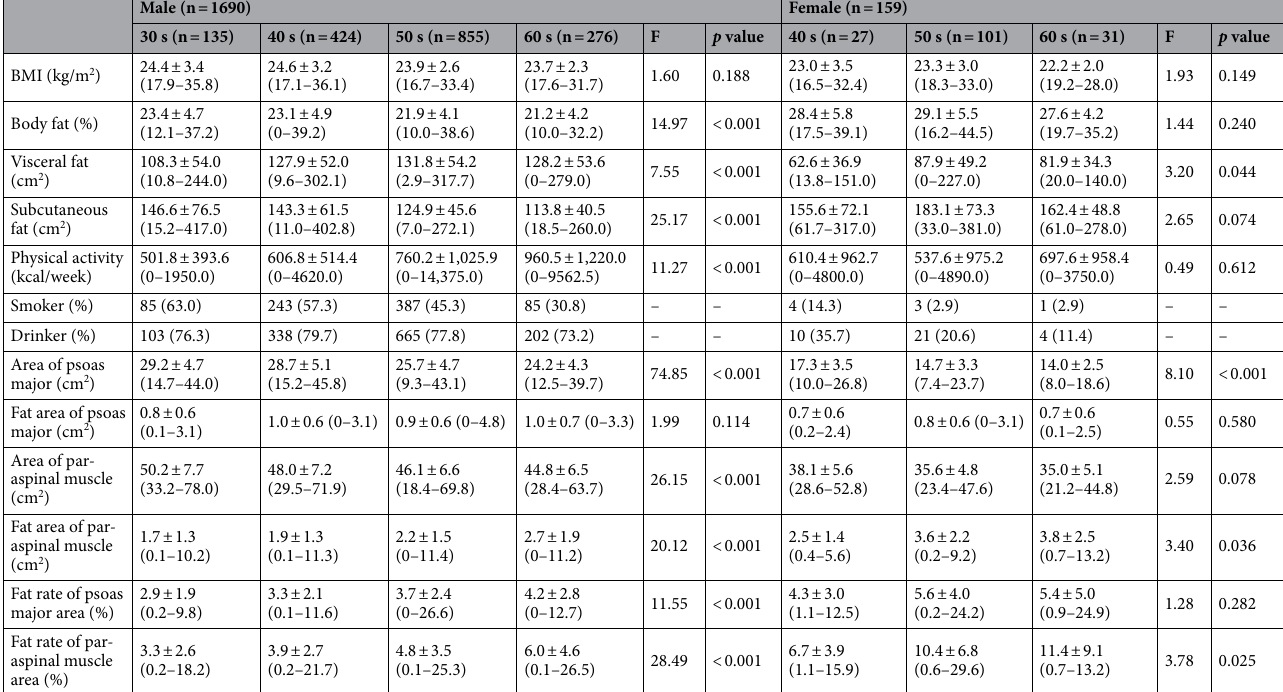
Table 1. Summary demographic and health characteristics of the individuals at baseline. Data are expressed as mean ± standard deviation (range) except smoker and drinker. BMI body mass